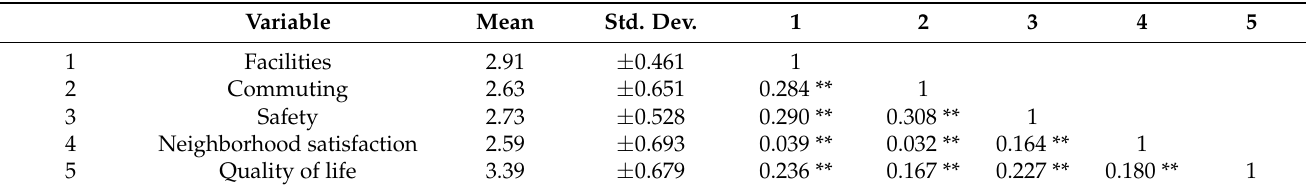
Table 3. Descriptive statistics and correlations between factors.